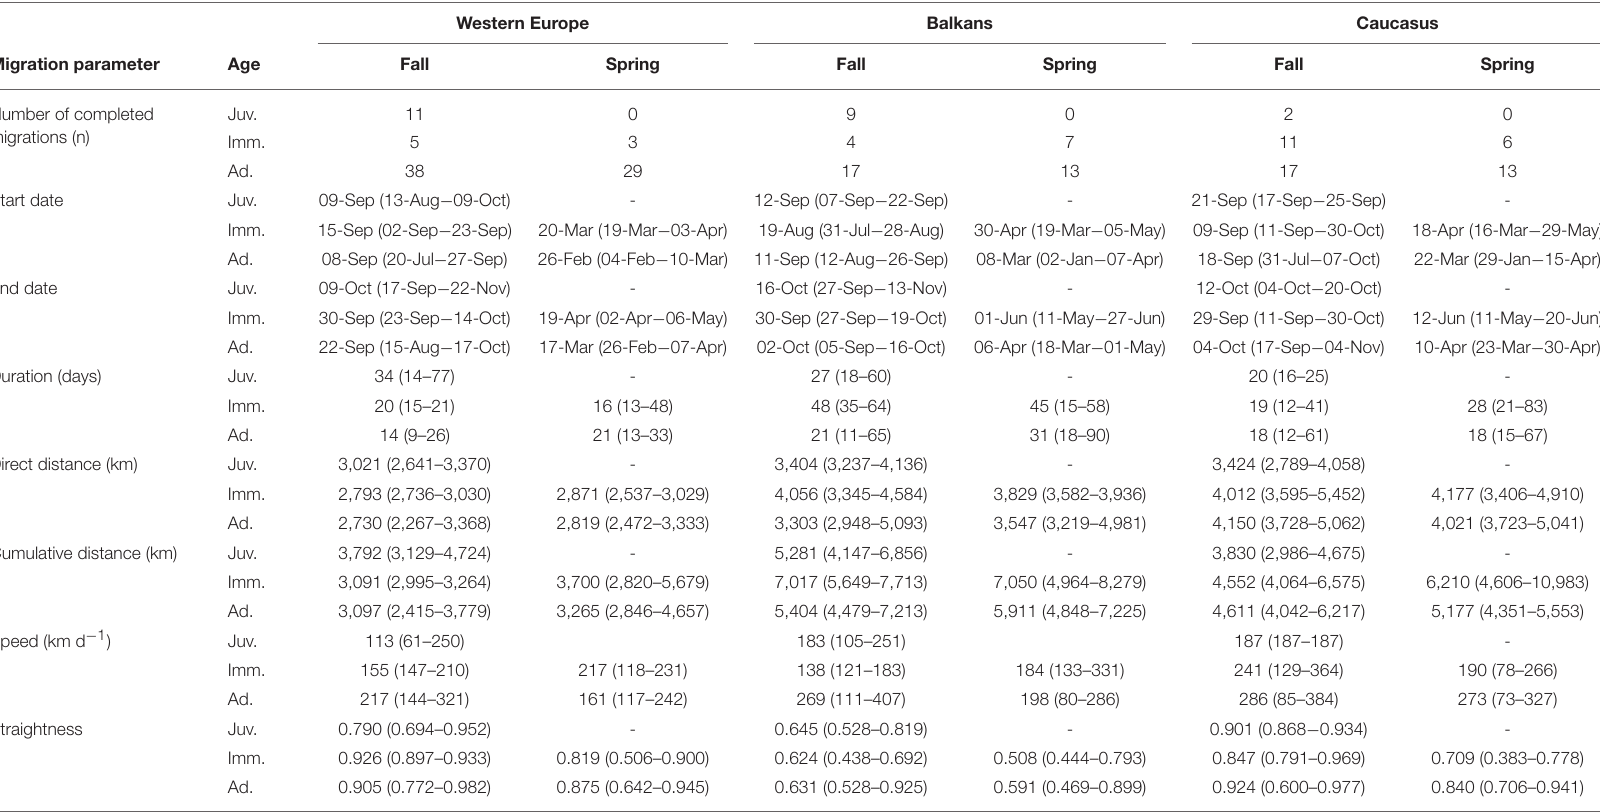
TABLE 1 | Median and range of migration parameters by season, age class at start of migration (Juv. = hatch year; Imm. = 2nd − 5th calendar year; Ad. = 6th calendar year and older) and